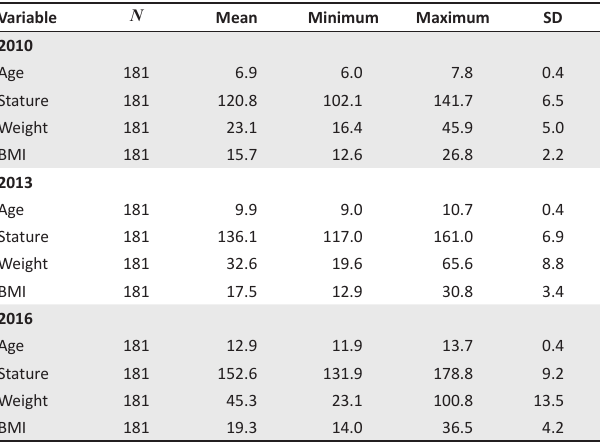
TABLE 2: Descriptive statistics for primary school boys over the period of 7 years (2010–2016). Variable